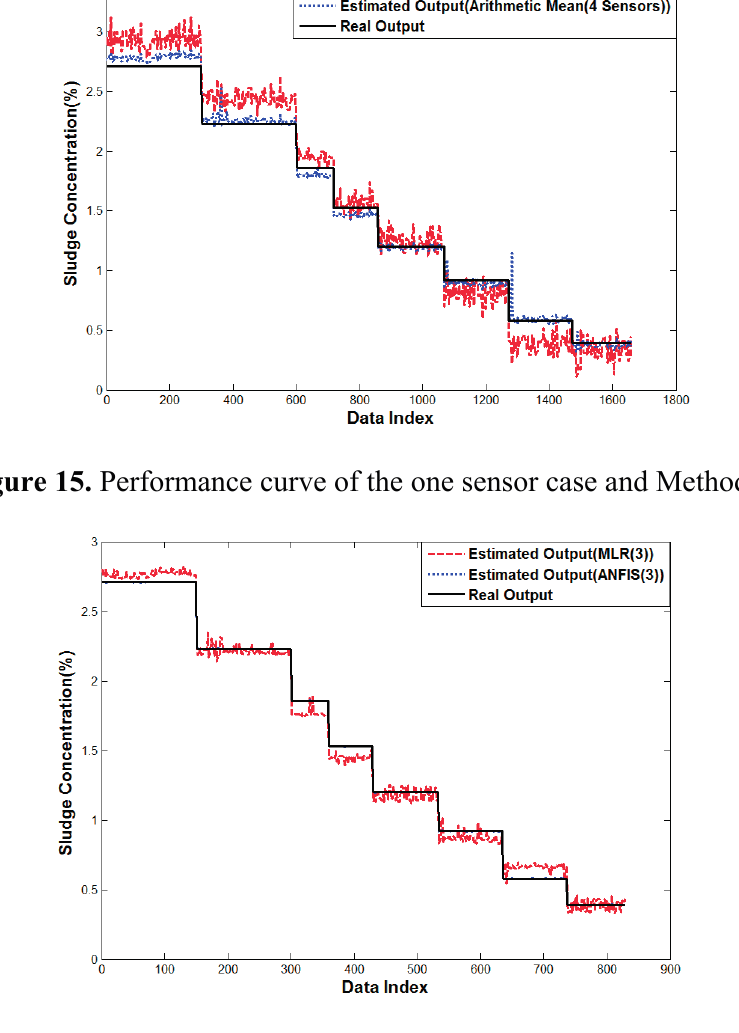
Figure 16. Performance curve of Methods 4 and